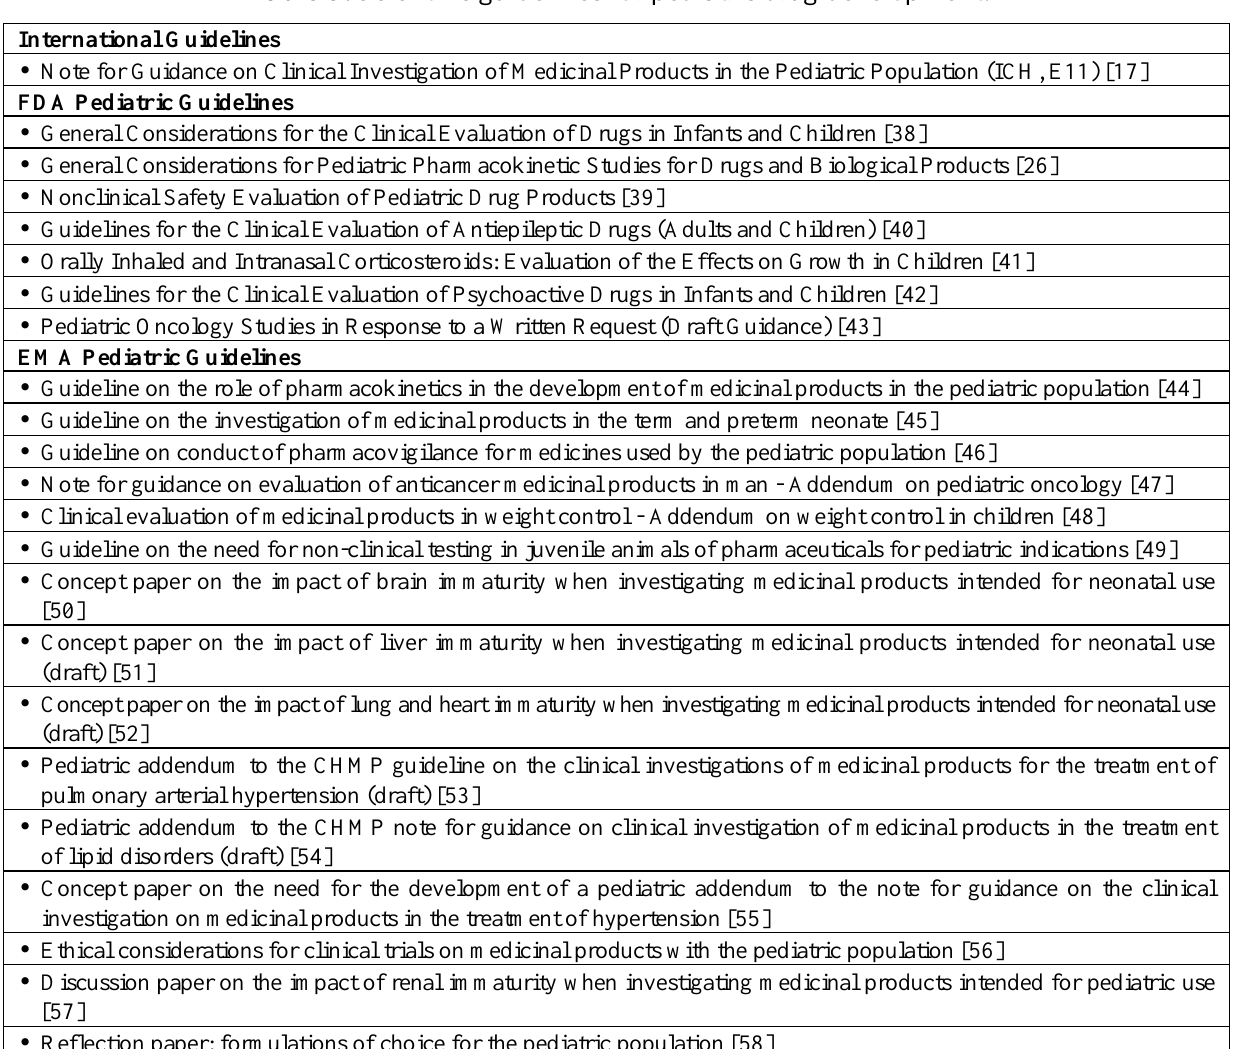
Table 5. Scientific guidelines for pediatric drug